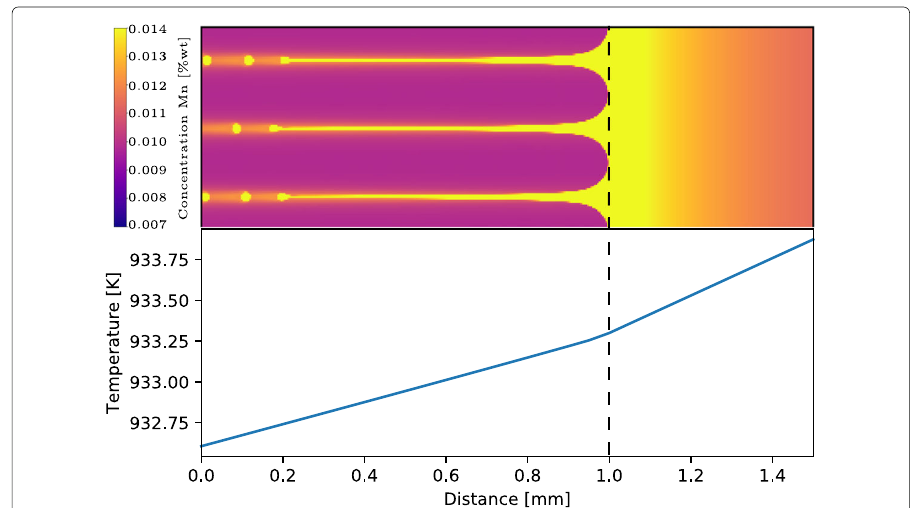
Fig. 13 Mn-concentration map (top) and temperature profile (bottom) for a state with (cid:7) G (cid:8) = 8.3 Kcm − 1 and V front = 11.4 μ ms −